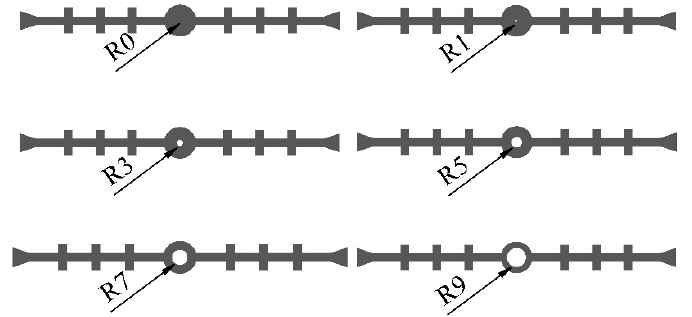
Figure 17. Waterstops I with different inner diameters of the middle hole (unit: mm).